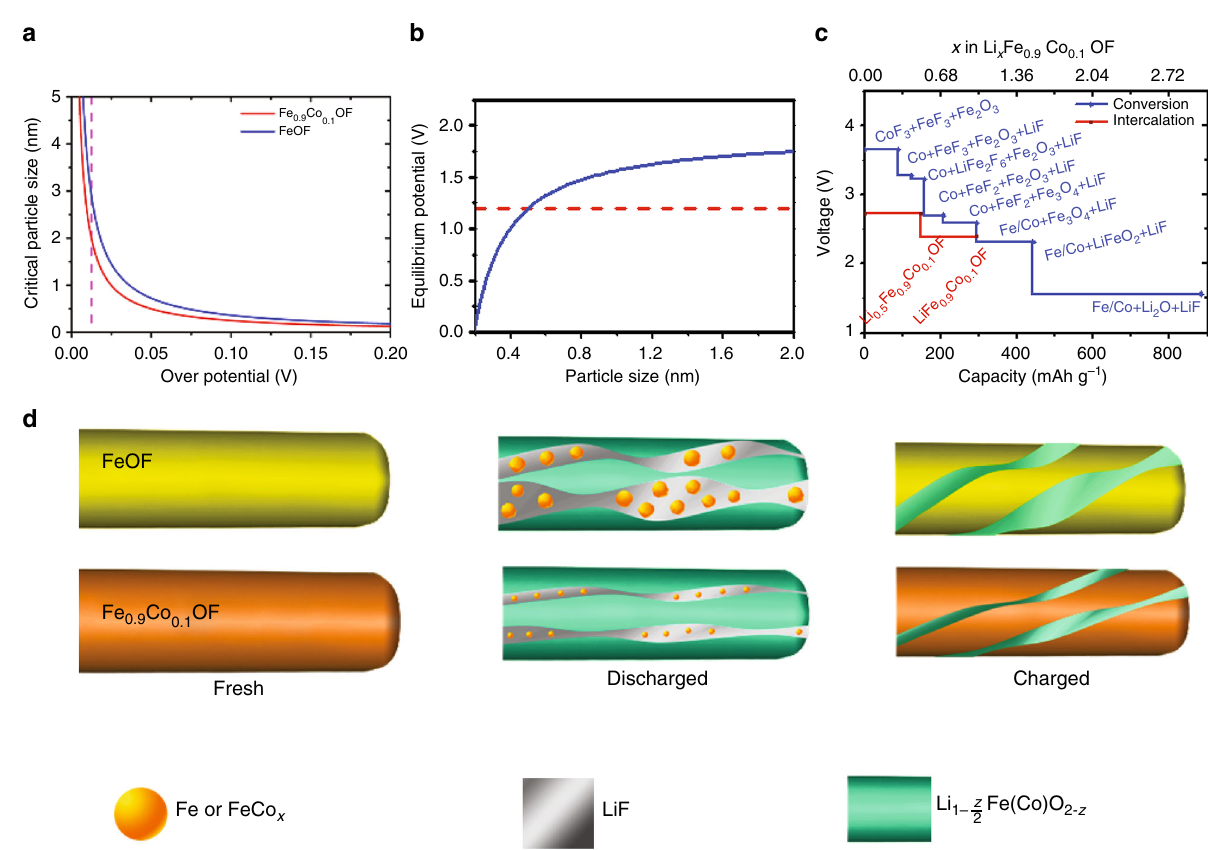
Fig. 5 Reaction mechanism for the Fe 0.9 Co 0.1 OF cathode. a The relationship between the overpotentials and the metal critical particle sizes during lithiation for FeOF and Fe 0.9 Co 0.1 OF. b The relationship between the in situ-formed metal particle size with the equilibrium potential of the conversion reaction. c Calculation reaction curves of the Fe 0.9 Co 0.1 OF materials from the DFT intercalation of Li into Fe 0.9 Co 0.1 OF, and the conversion path using the equilibrium phases (assuming the size of metal particles is 1 nm). d Illustrations of structural evolution for FeOF and Fe 0.9 Co 0.1 OF during